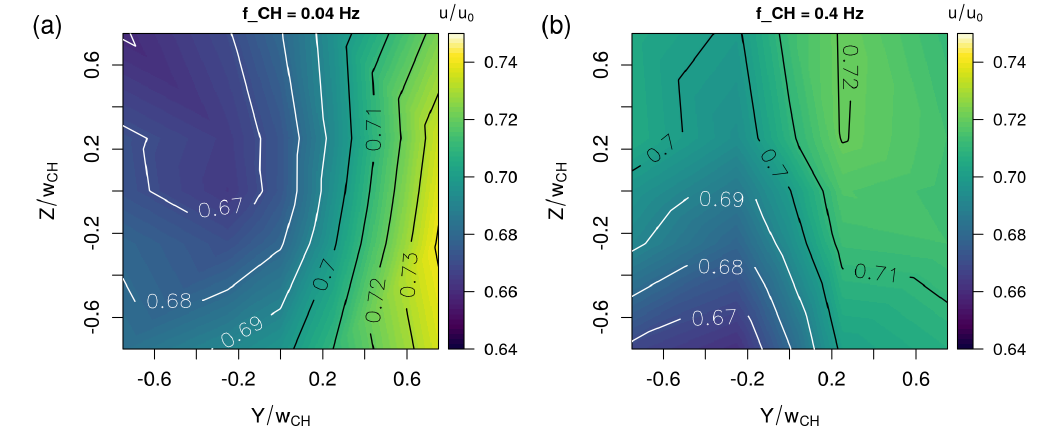
Figure 8. Interpolated surface plot of the mean velocity of the inverse gust in the YZ plane 8.675 w CH downstream of the chopper blade for = 0 . 04Hz and (b) f = 0 . 4Hz. (a) f CH CH 2 1